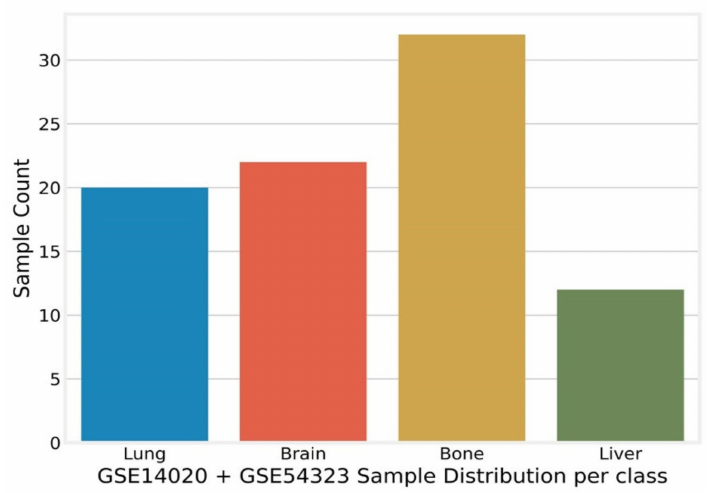
Figure 8. Merged Dataset Class